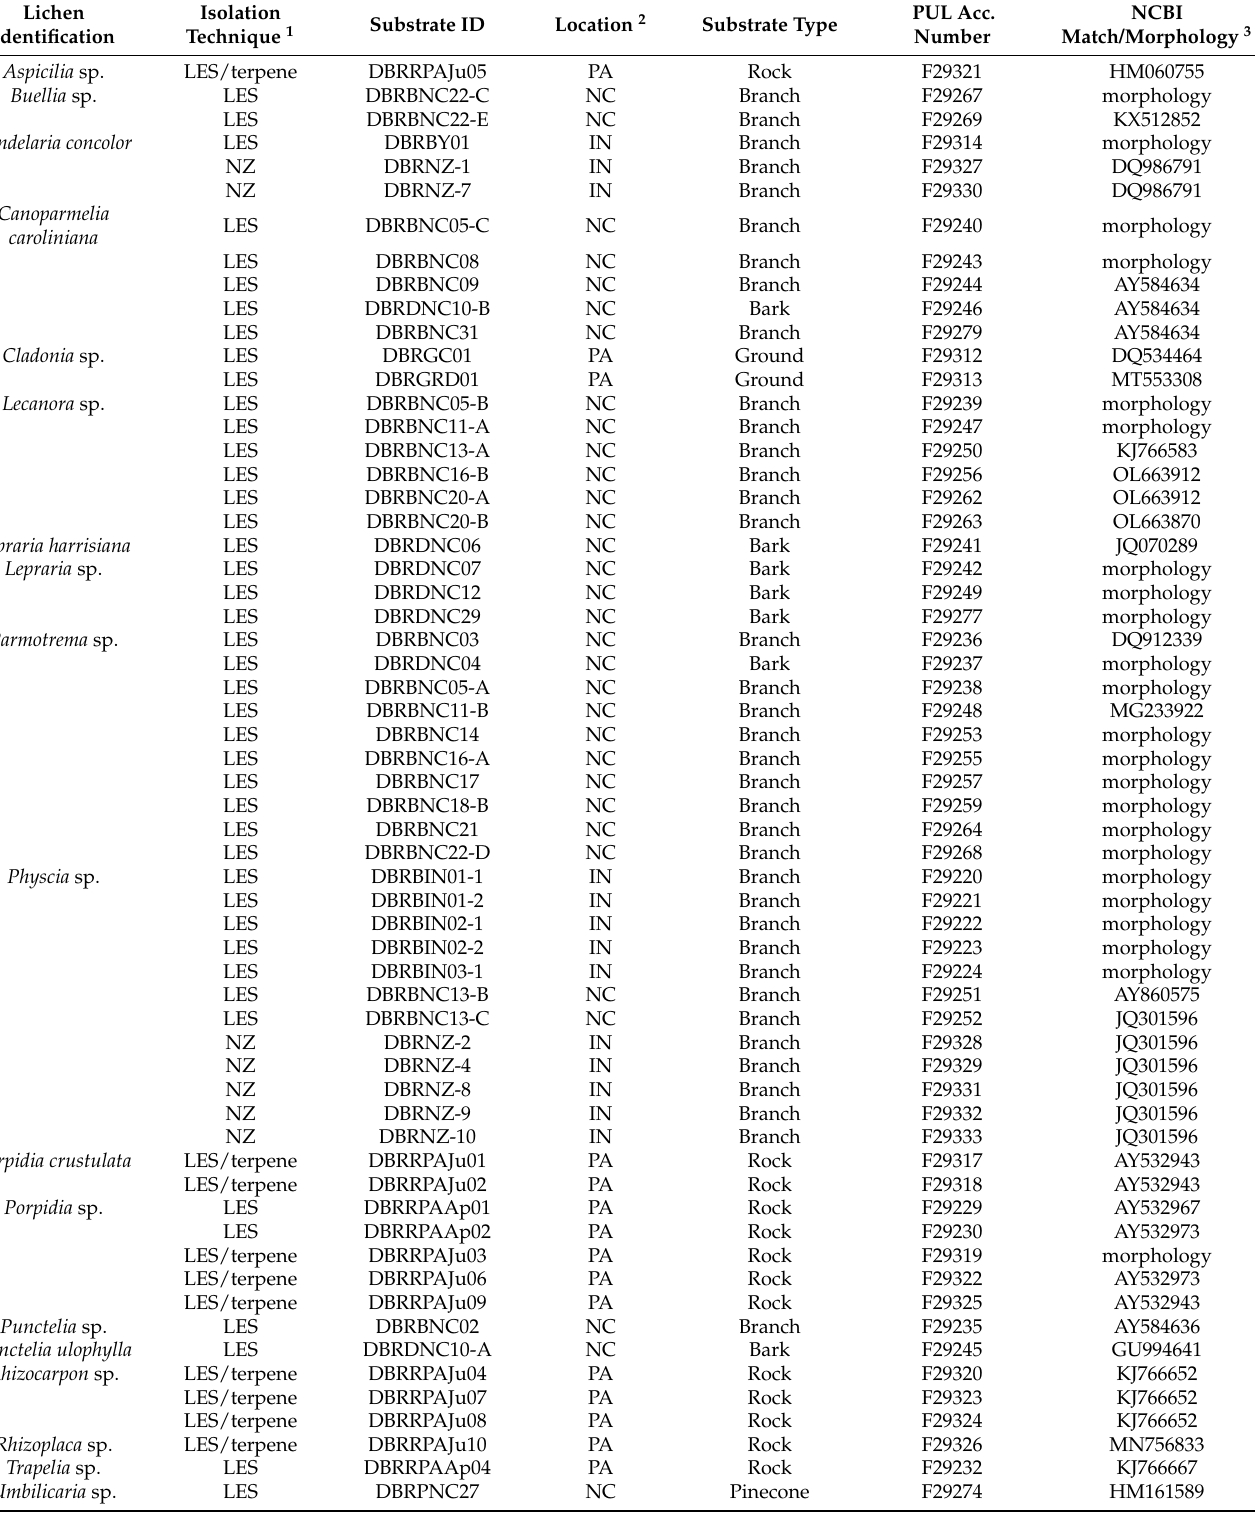
Table 1. Identified lichen samples utilized in this study based on NCBI BLASTn